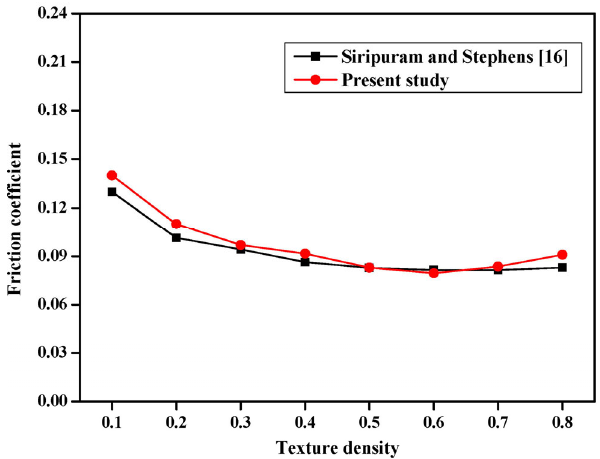
Fig. 4 Friction coefficient of square textured unit cell.